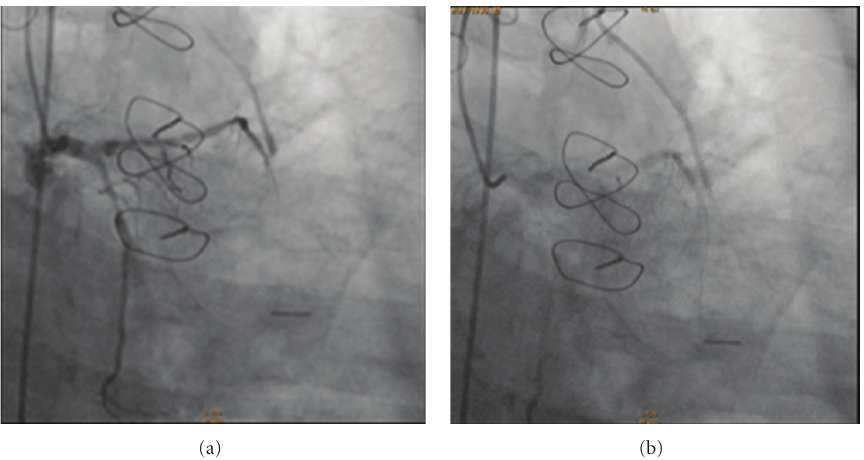
Figure 1: Reversal of flow of dye in left internal mammary artery graft to left anterior descending artery.